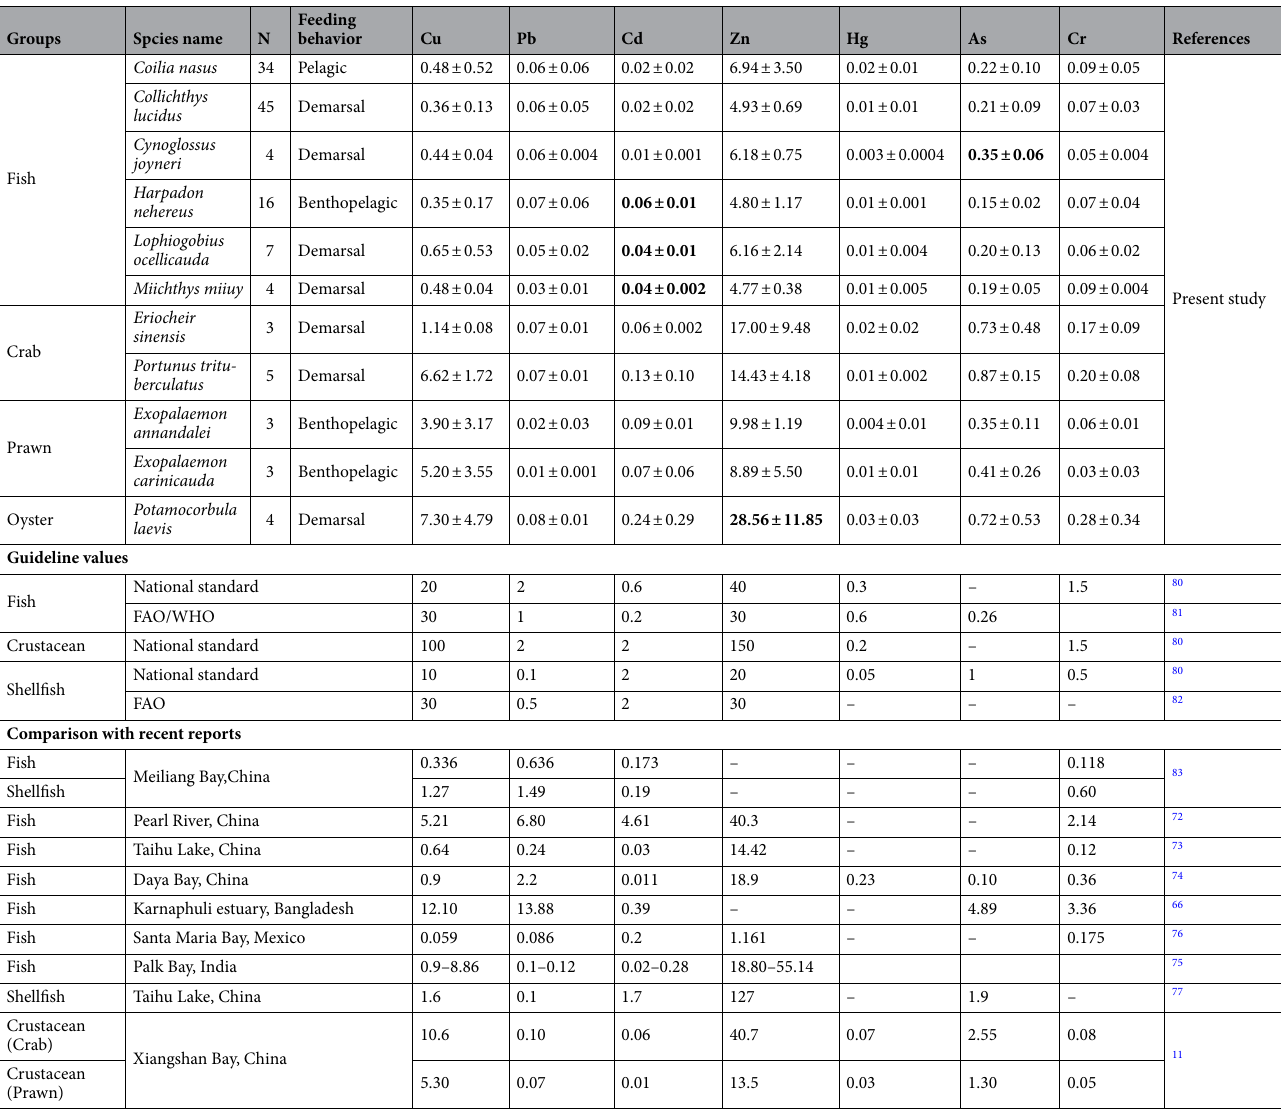
Table 1. Heavy metal concentrations (mg/kg) in targeted species, their feeding behavior, comparison with guideline values and related studies (values in bold denote the exceeded permissible